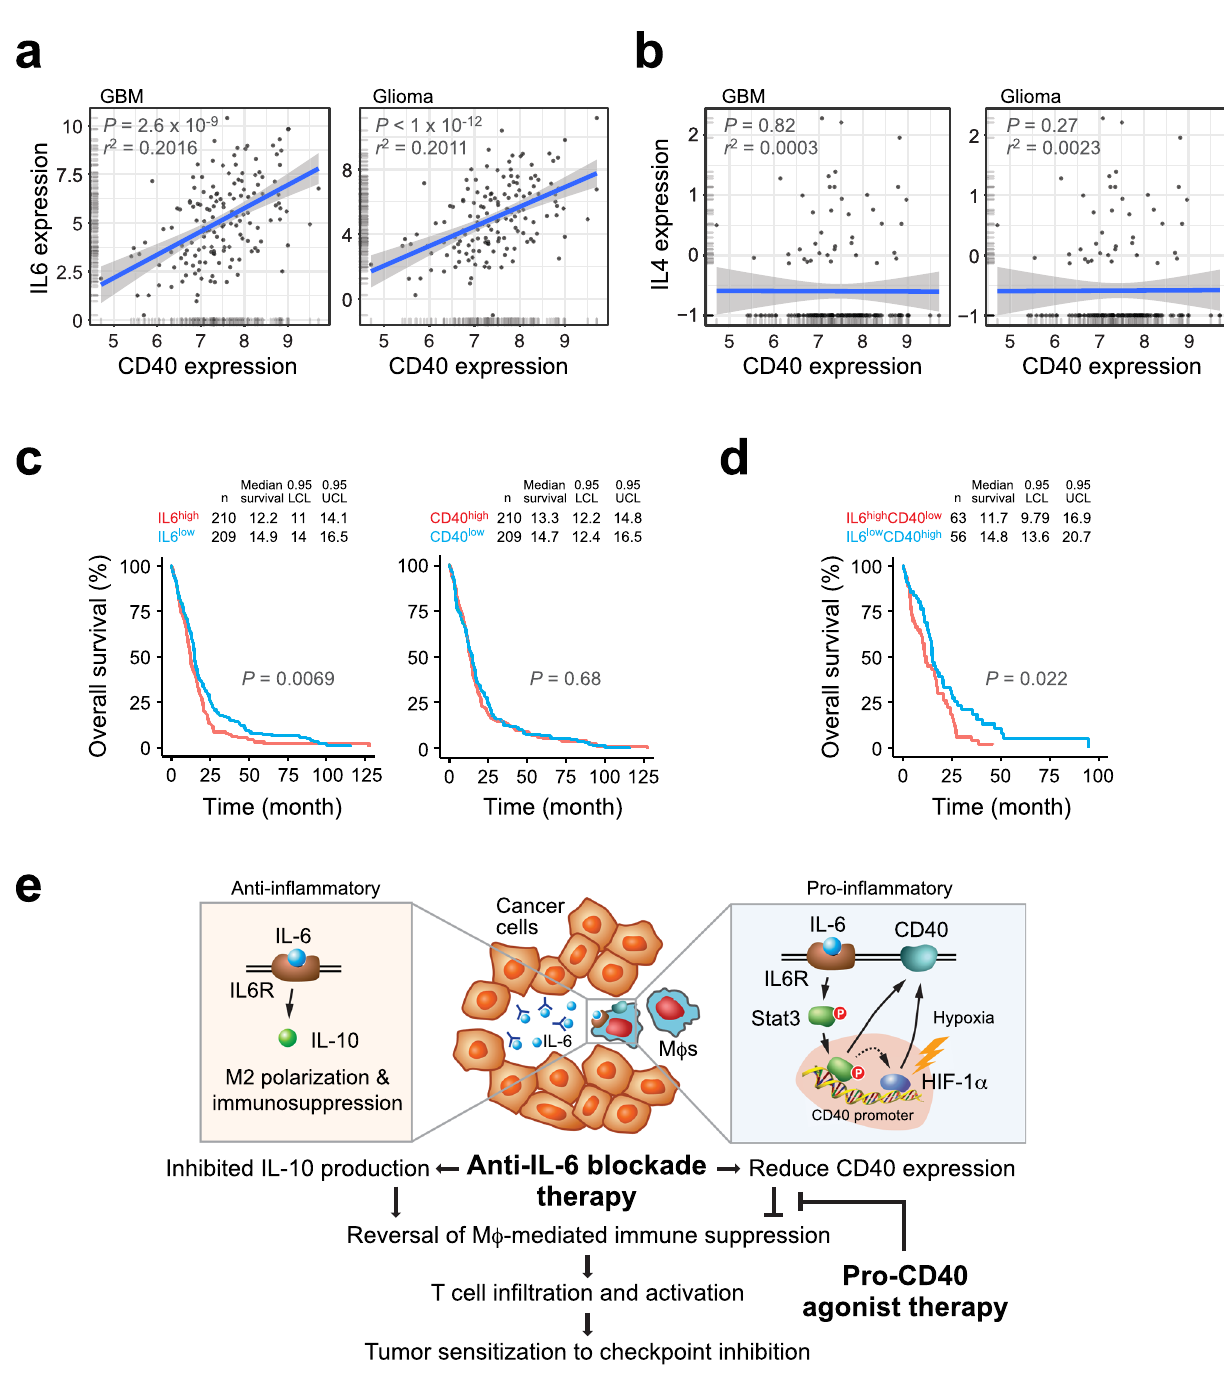
Fig. 7 High IL-6 expression and low CD40 expression correlate with poor survival in human GBM patients. a , b Correlation of CD40 expression with a IL- 6 and b IL-4 expression was subjected to linear regression analyses using GlioVis/TCGA GBM-RNA-seq ( n = 160 patients) and low-grade glioma ( n = 513 patients) data sets. Statistical analysis by linear regression analysis. c , d Correlation of IL-6 and CD40 expression (high/low cutoff of 40%) with overall survival was analyzed using TCGA-Firehose data set. Statistical analysis by two-sided log-rank test. e A schematic model. IL-6 induces anti-in fl ammatory and pro- in fl ammatory functions in M ϕ s, through IL-10 and CD40 expression, respectively. Combination therapy by anti-IL-6 neutralization and CD40 activation reverses M ϕ -mediated tumor immunosuppression and promotes T-cell in fi ltration and activation, sensitizing tumor to checkpoint inhibition treatment. Statistical analysis . All grouped data were presented as box plot in fi gures. Sta- Reporting summary . Further information on research design is available in the Nature tistical analysis was performed using Student ’ s t -test or analysis of variance for Research Reporting Summary linked to this article. experiments with two groups or more than two groups, respectively. Kaplan – Meier survival curves were generated using Prism software and log-rank test was per- Data availability formed to assess statistical signi fi cance between groups in mouse experiments. The RNA-seq data have been deposited in NCBI ’ s Gene Expression Omnibus (GSE151213). survival analysis of TCGA (Glioblastoma, Firehose Legacy) and GlioVis data sets Gene expression and survival data of glioma patients were obtained from TCGA (https:// was conducted using R software (Version 3.6.3). A two-sided P -value< 0.05 was portal.gdc.cancer.gov) and GlioVis (http://gliovis.bioinfo.cnio.es/). The remaining data considered signi fi cant. NATURE COMMUNICATIONS| (2021) 12:3424